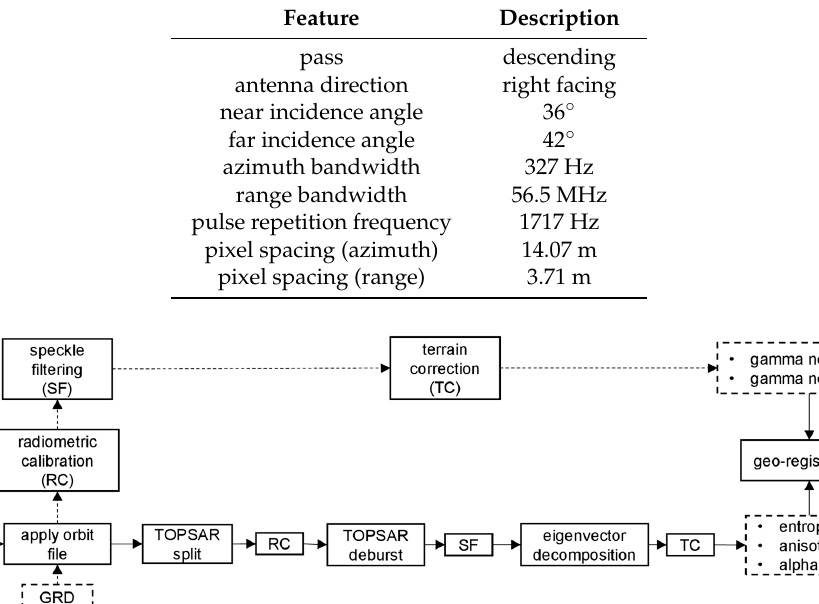
Figure 3. The work flow for Sentinel ‐ 1 image processing. The broken rectangles represent input or output data. The input data are single look complex (SLC) and ground range detected (GRD). The solid rectangles depict the processes conducted, the solid connected arrows indicate the processing steps for SLC while broken arrows connect processes performed over GRD. The output data for SLC were polarimetric scattering entropy, scattering anisotropy and mean scattering alpha angle while that of the GRD are backscattering coefficients in gamma nought for both